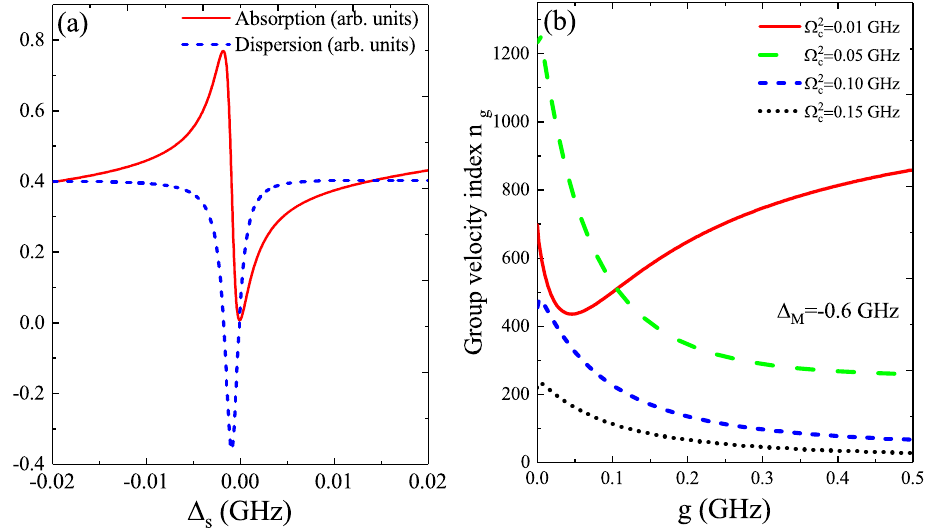
Figure 4. ( a ) The absorption and dispersion as a function of ∆ s at fixed ∆ M = − 0.6 GHz. ( b ) The group velocity index n g versus the QD–MF coupling g for four different Rabi frequencies Ω 2 c under the parameters of β = 0.06, ∆ M = − 0.6 GHz, and ∆ c = ω m